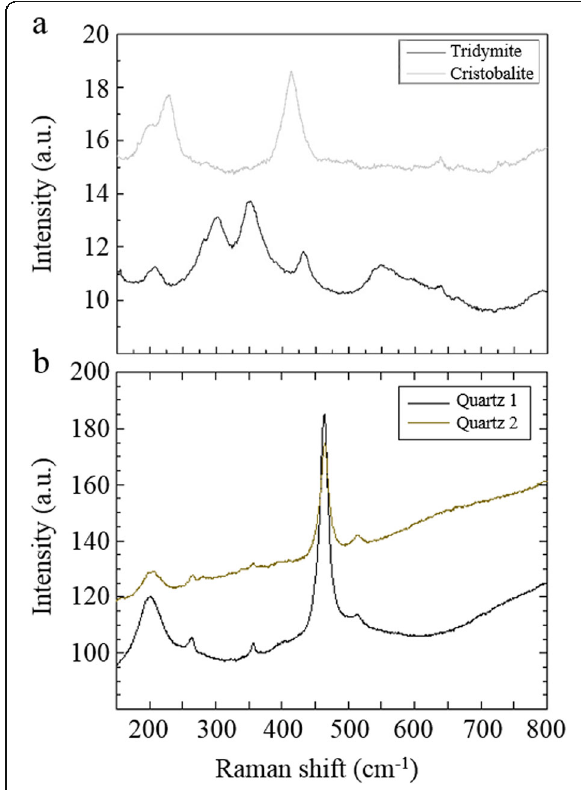
Fig. 4 Representative Raman spectra of a tridymite and cristobalite and b quartz in the silicic clast. Raman bands of tridymite at 207, 301, 351, and 432 cm − 1 , cristobalite at 228 and 411 cm − 1 , and quartz at 199 and 464 cm − 1 (e.g., Etchepare et al. 1974; Ling et al. 2011; Seddio et al. 2015) were